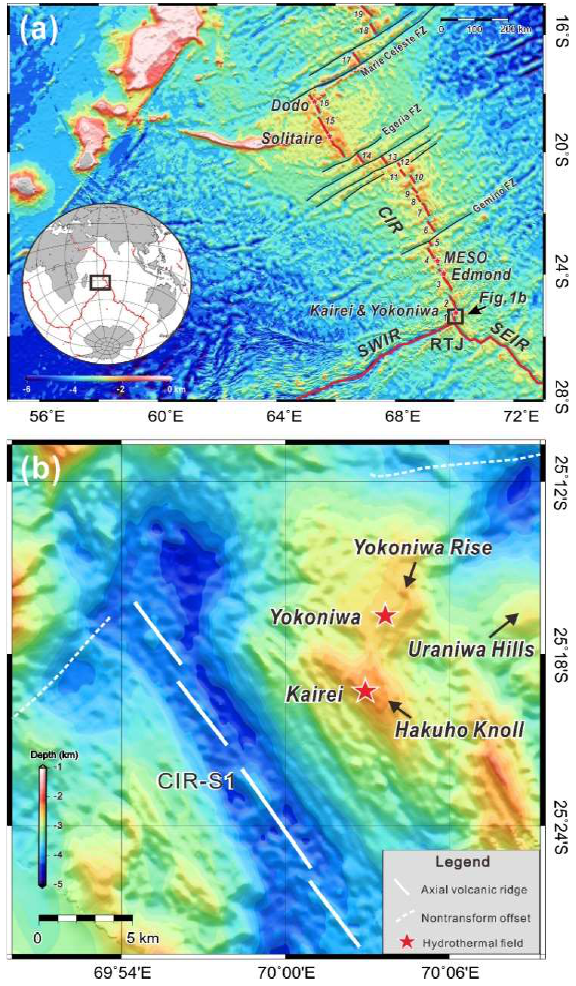
Figure 1. ( a ) Geological map of the Central Indian Ridge (CIR) and ( b ) location of the Kairei vent field. Other known hydrothermal fields are indicated by red stars. Note, segment numbering is from Okino et al. (2015) [28]. SWIR = Southwest Indian Ridge; SEIR = Southeast Indian Ridge. Bathymetry data source: Global Multi-Resolution Topography (GMRT) synthesis